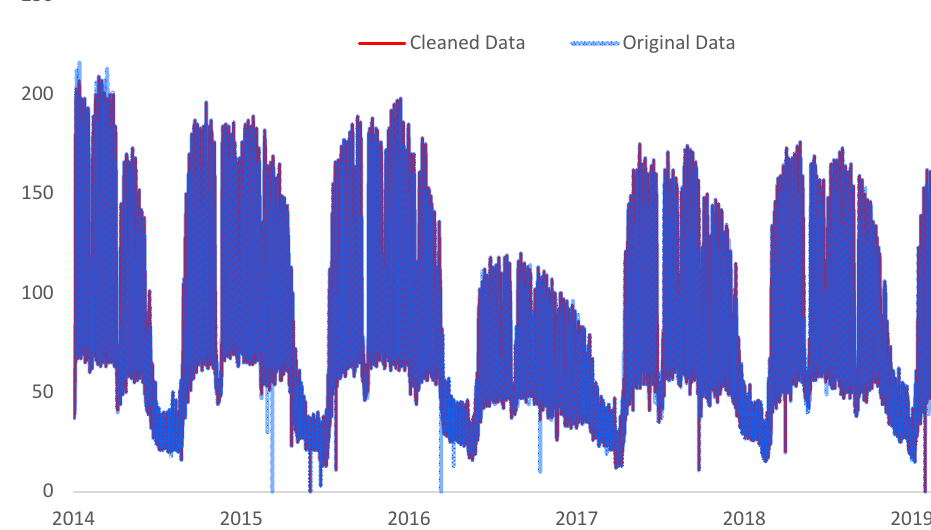
Figure 8. Original and cleaned data for Marasti Students Campus location.